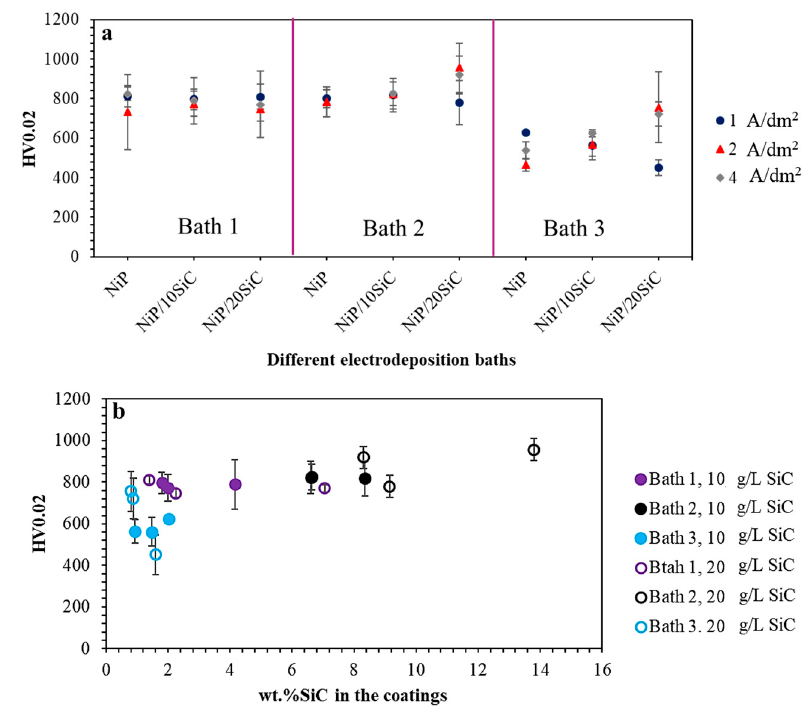
Figure 7. ( a ) Microhardness values of the coatings at different conditions; ( b ) the relation between microhardness and wt.% SiC.